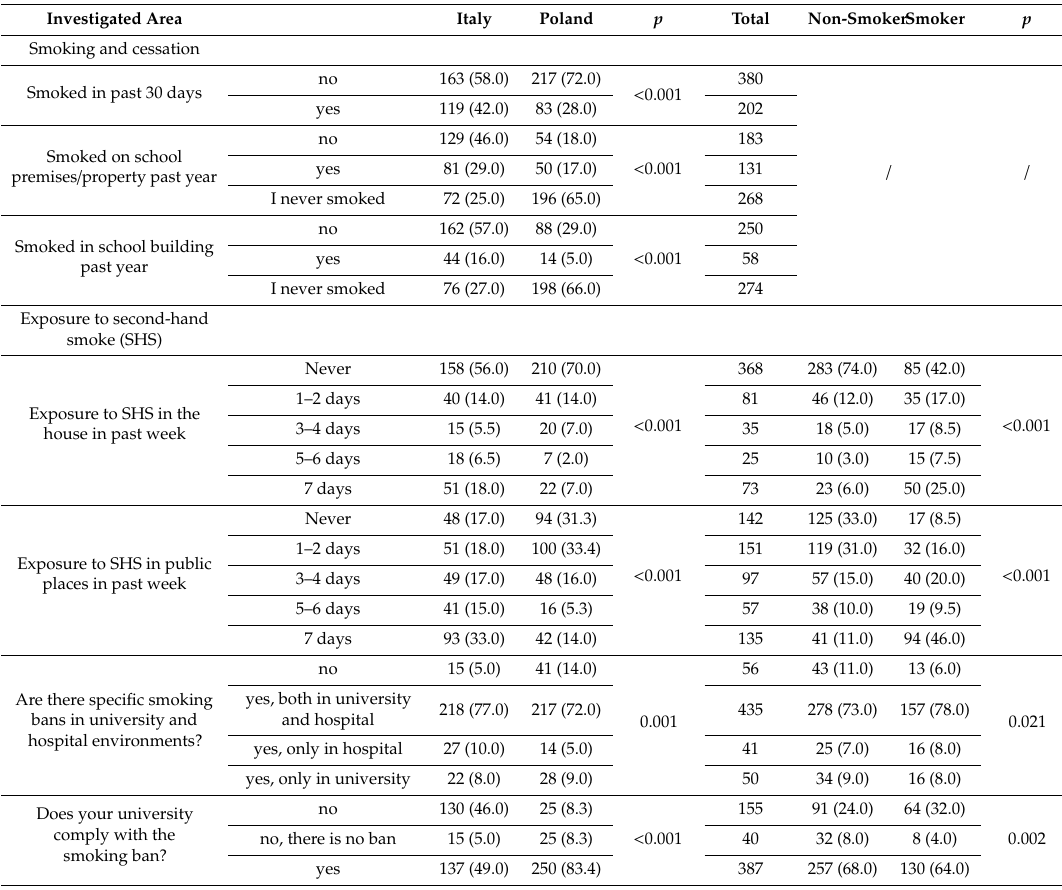
Table 2. Smoking and exposure to second-hand smoke (SHS) in dental